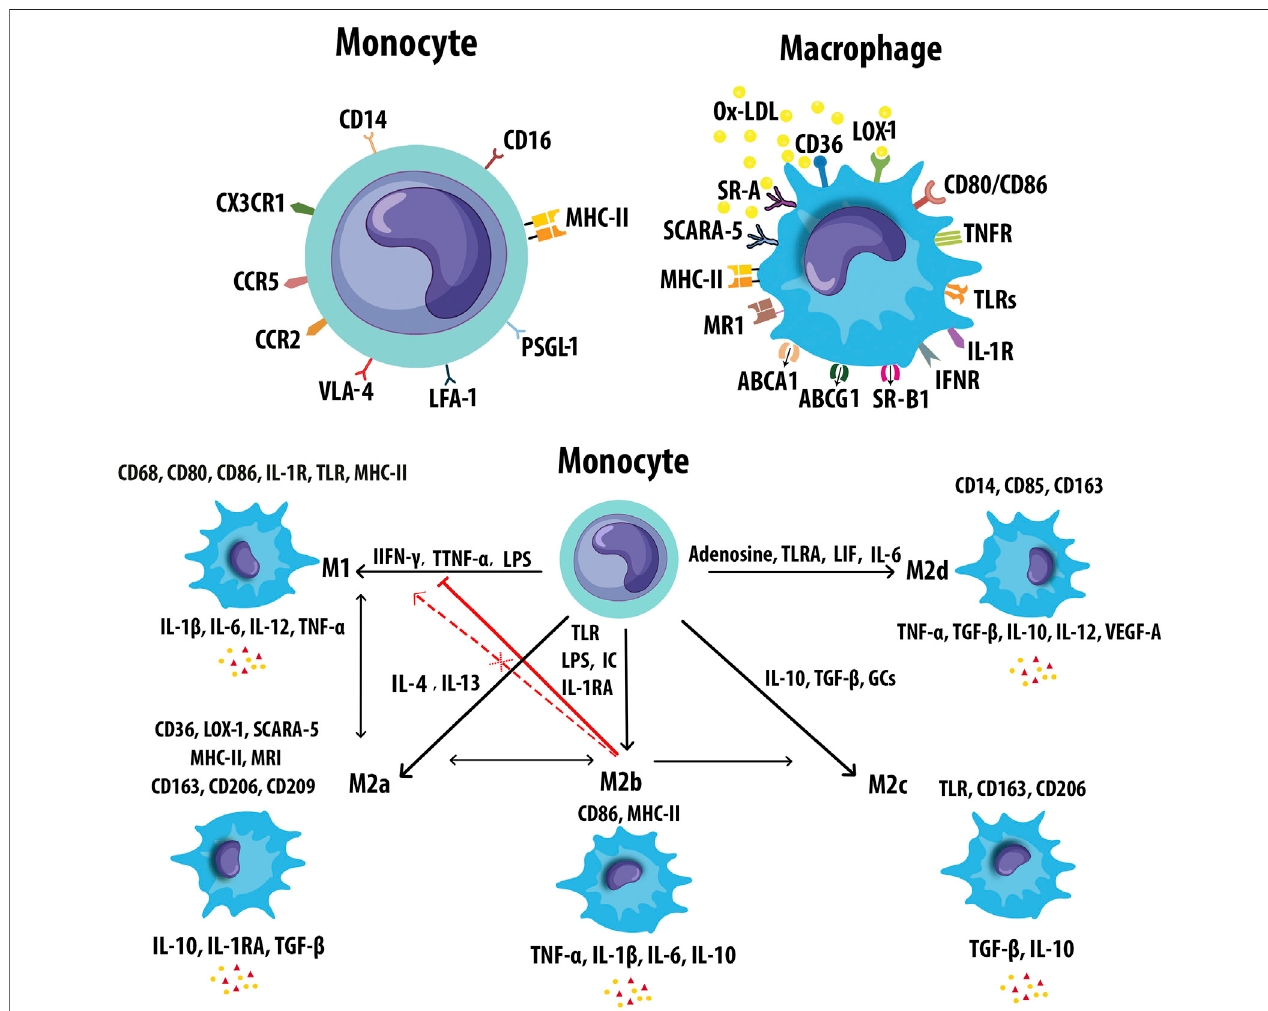
FIGURE 5 | Markers of monocyte and macrophages. (A) Monocytes and macrophages express an ample variety of receptors that modulate monocyte and M φ activation. (B) M φ scanpolarizetoM1orM2(M2a,M2b,M2c,andM2d)inresponsetodifferentinducersand secretepro-andanti-in fl ammatorycytokinesrespectively. M2b M φ scanconverttotheotherM2subtypesinresponsetoactivatedfactors.M2bM φ sinhibittheconversionfrommonocytetoM1M φ s.M2balsocannotrepolarize to M1 during exposure to M1 inducer. Leukemia inhibitory factor (LIF), mannose receptor (MR).